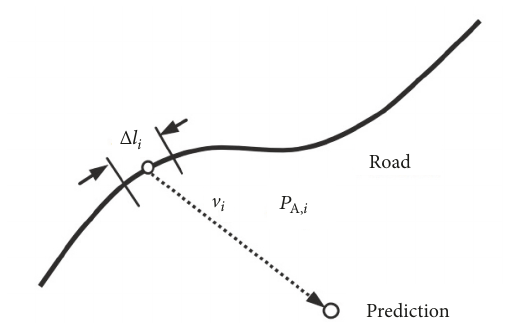
Figure 3: Sound propagation from a sound source to a prediction point